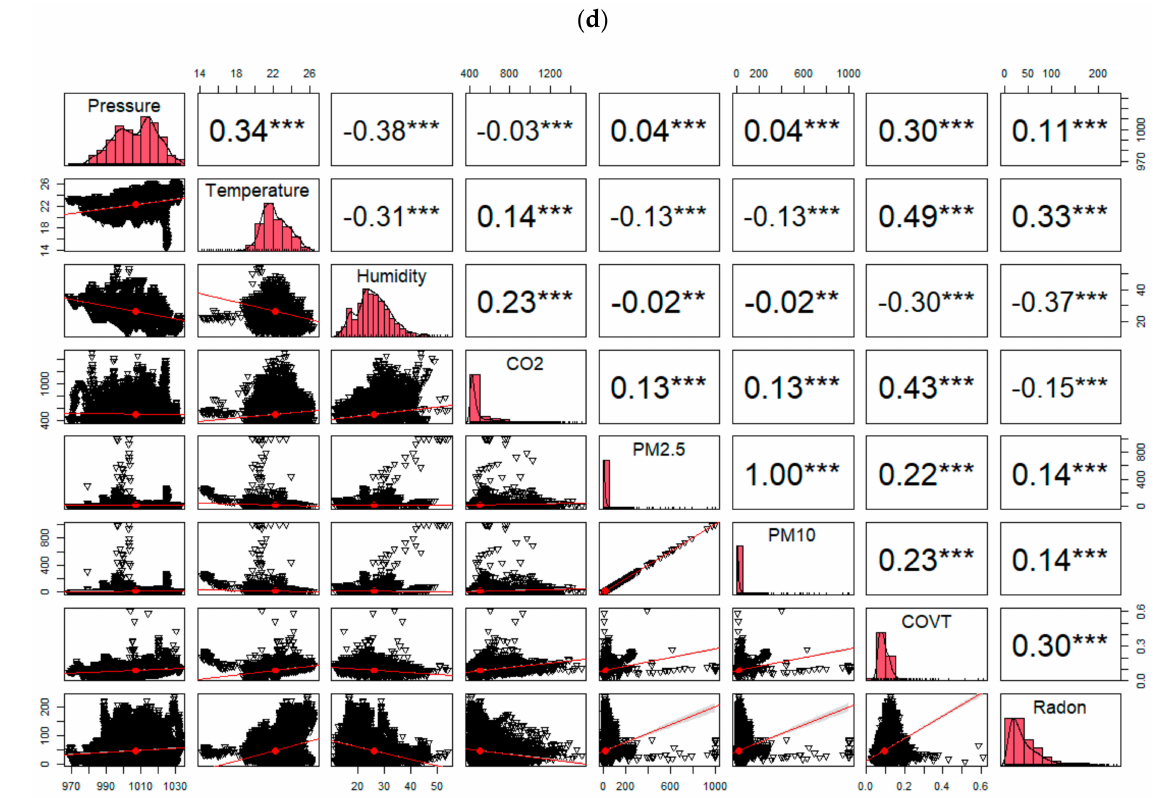
Figure 5. Correlations of IAQ parameters for air in the rooms: ( a ) A, ( b ) B1, ( c ) C1 and ( d ) C2.